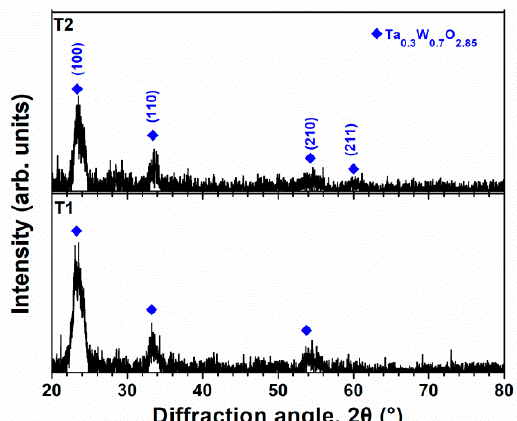
◦ C in 1% O 2 –Ar for 8